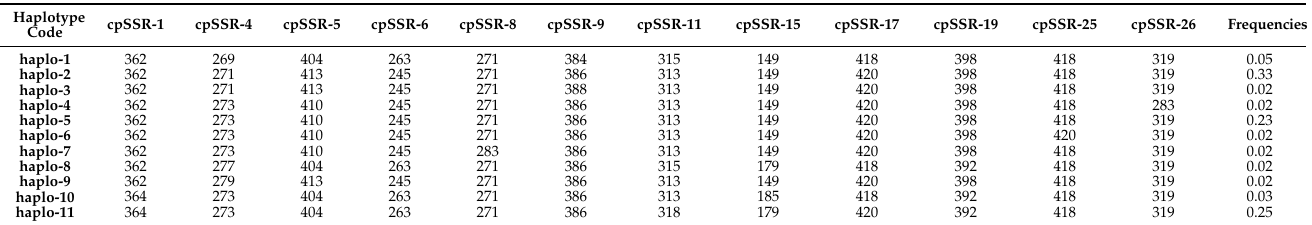
Table 4. The identified haplotypes and their frequencies based on 12 cpSSR markers among 60 tree peony